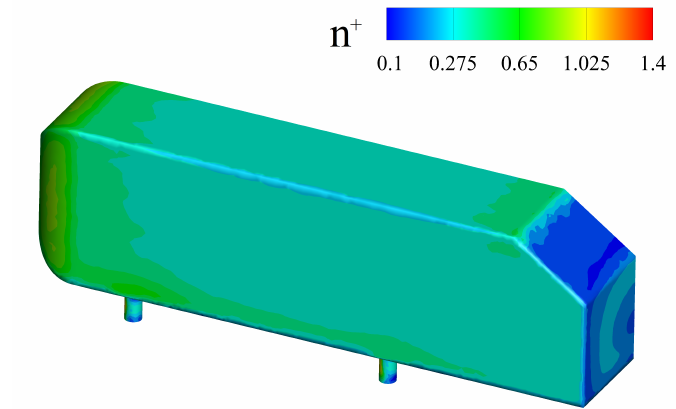
Figure 3. Distribution of mean n + on the Ahmed body surfaces at Reynolds number of Re = 7.68 × 10 5